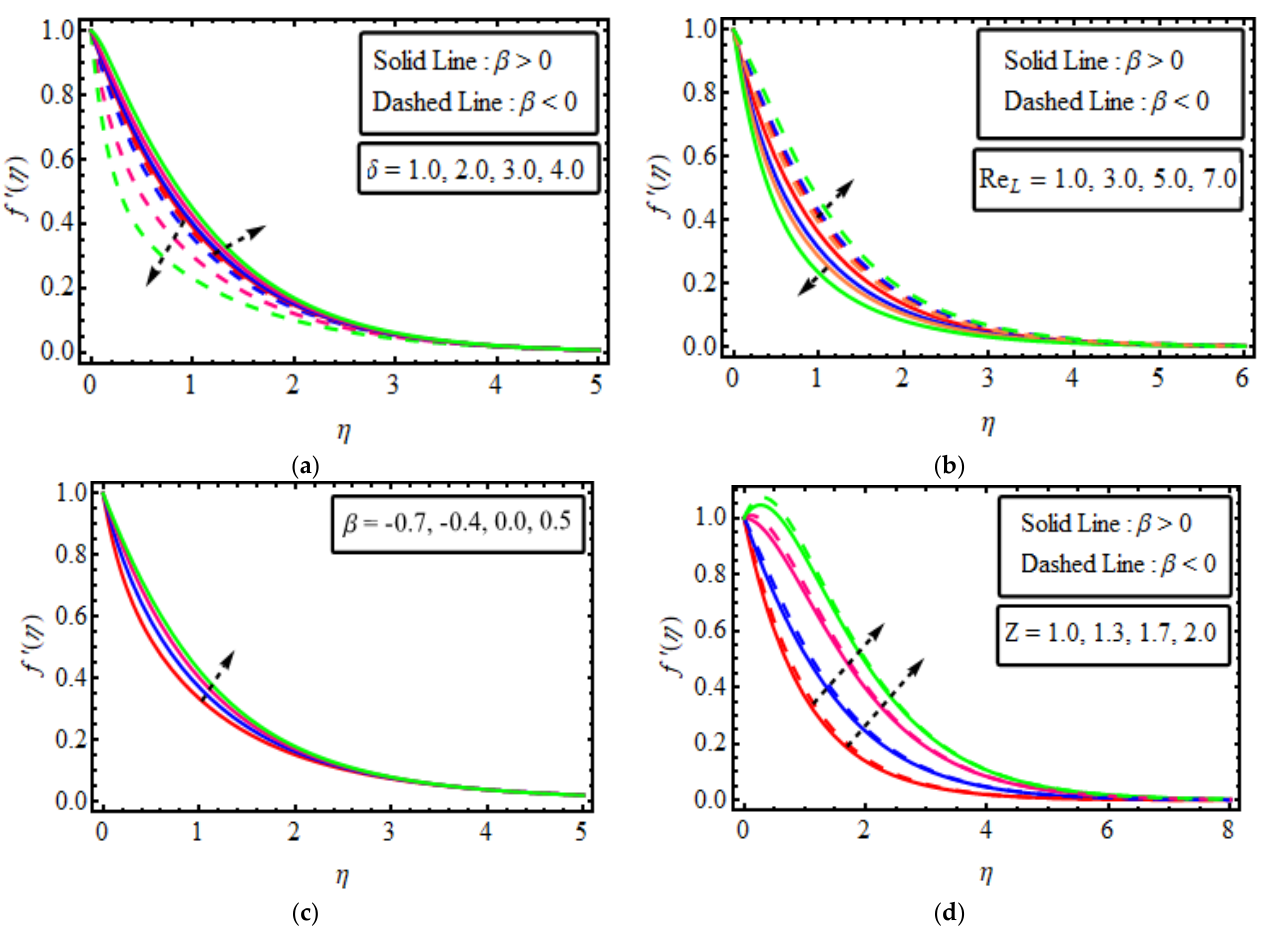
Figure 2. Plots of ( a )  the curve of W'(0) . w